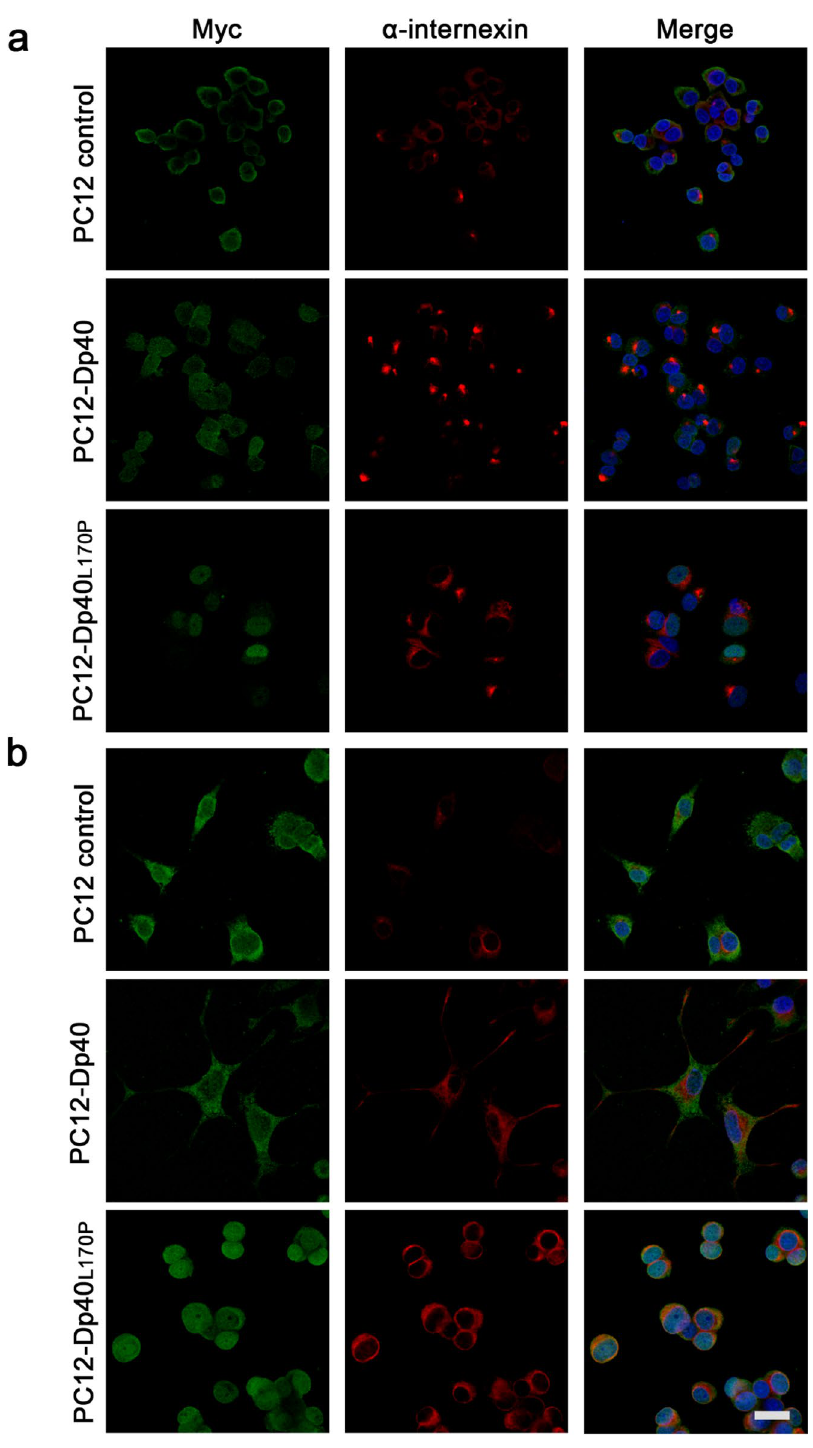
Figure 5. Cellular distribution of α-internexin in undifferentiated and NGF-differentiated PC12-Dp40 and PC12-Dp40 L170P cells. ImmF was performed on the PC12-Dp40, PC12-Dp40 L170P and PC12 control cells after the induction of differentiation. ImmF staining for the Myc-Dp40 and Myc-Dp40 L170P proteins was performed using the anti-c-Myc antibody (green) and α-internexin (red). Nuclei were stained with DAPI (blue). Images represent a single equatorial Z-section from confocal images to show the localization of each protein. ( a ) Undifferentiated and ( b ) differentiated PC12 control, PC12-Dp40 and PC12-Dp40 L170P cells. Merged images correspond to the overlap of Myc-Dp40 and Myc-Dp40 L170P with the α-internexin protein. The figure is a representative result of three independent experiments. The scale bar represents 20